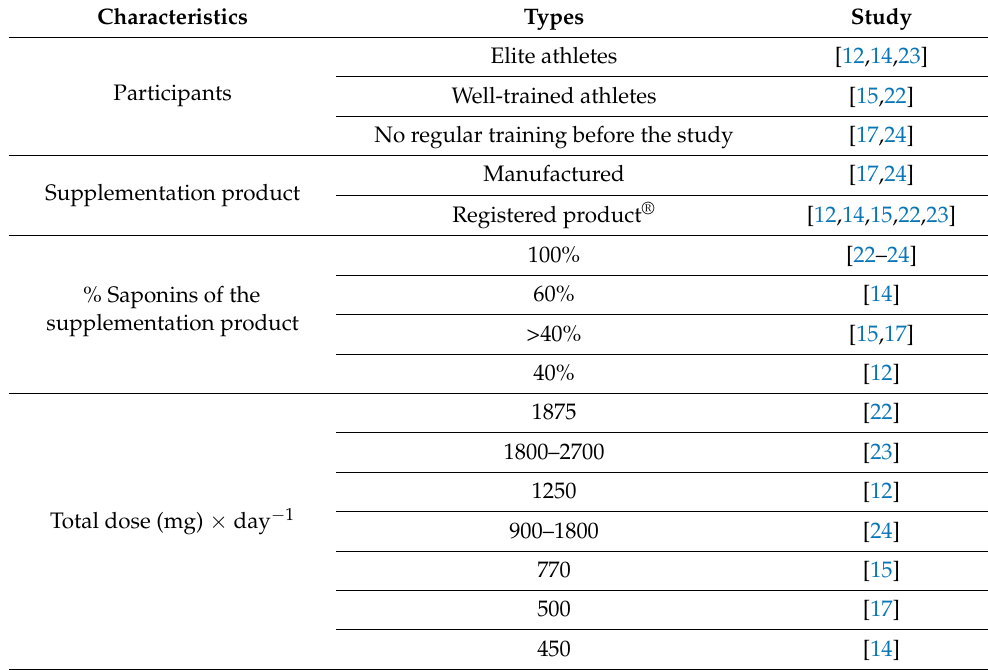
Table 2. Characteristics of participants and supplementation protocols of the selected